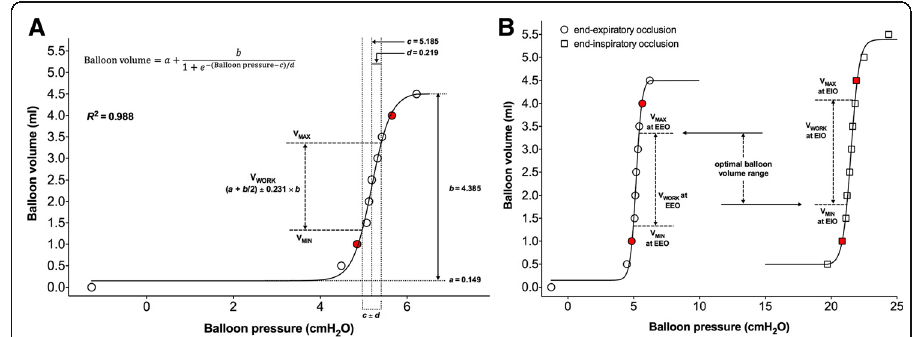
Fig. 2 An example of the fitted balloon volume-pressure curve using the sigmoid regression equation. a